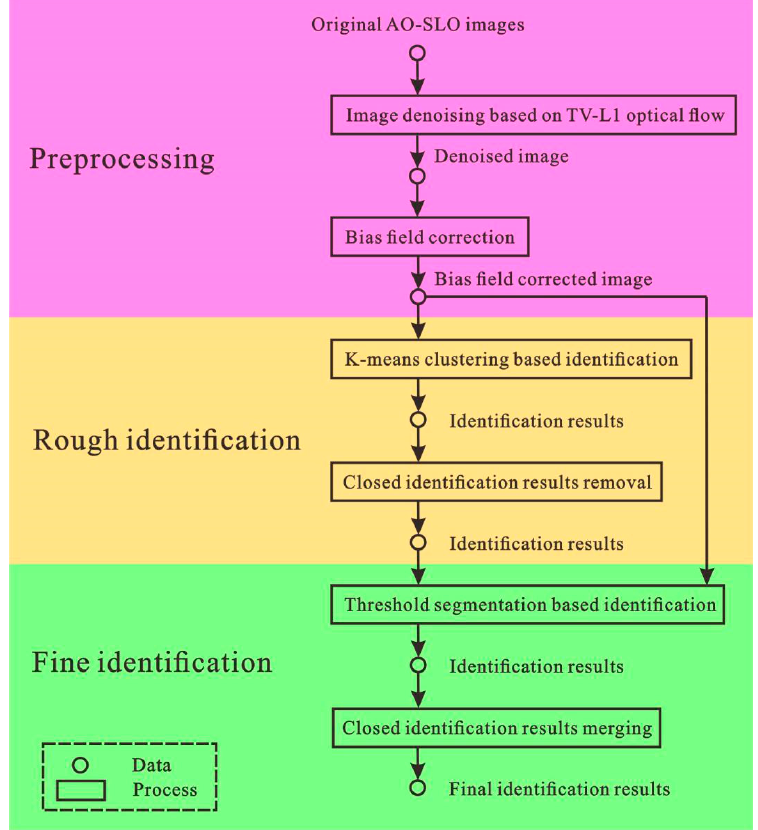
Figure 1. Flowchart of proposed method for automated cone cell identification.